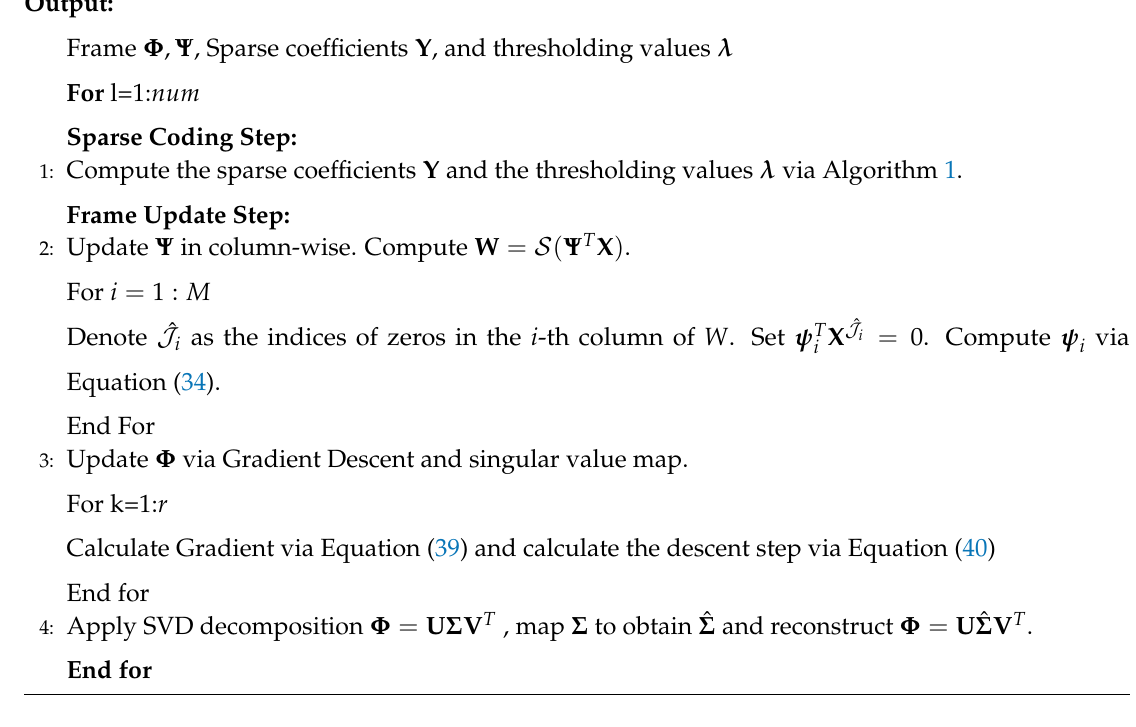
Algorithm 2 Dictionary pair learning